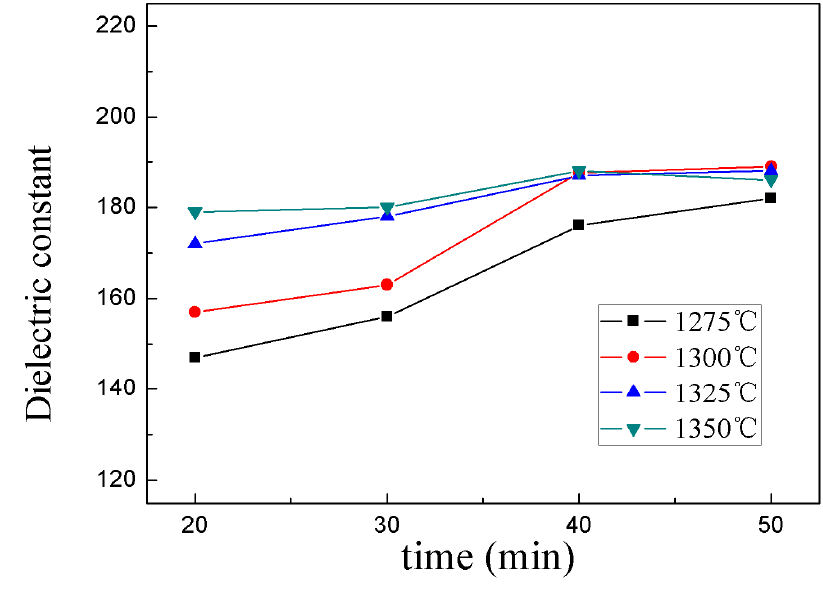
Figure 4. Dielectric constant ε r of the 0.95CST–0.05BNT samples with different sintering temperatures and holding times by MWS.